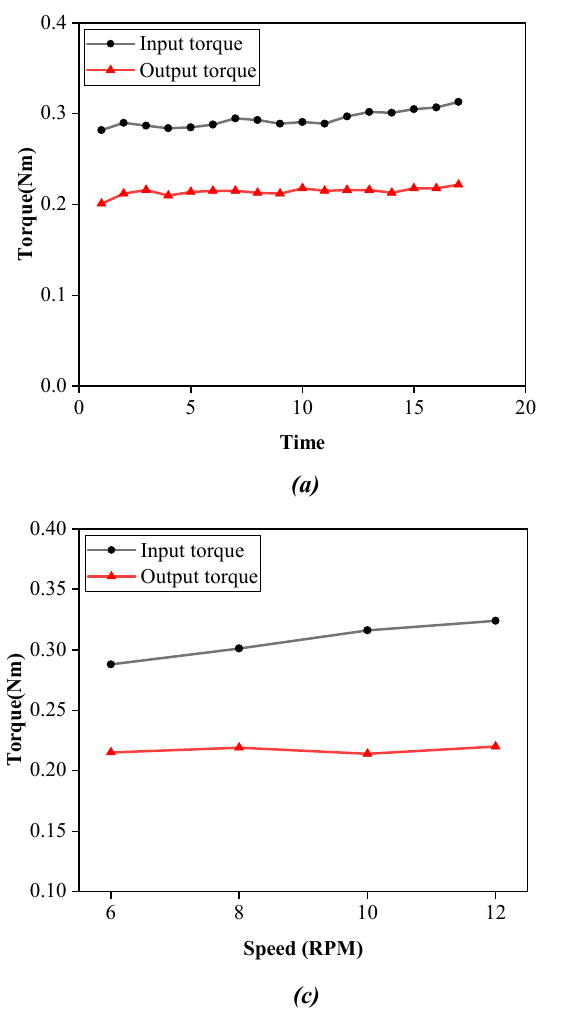
Figure 10. Experimental data curve of lasso input and output characteristics. ( a ) Data diagram of lasso input and output torque; ( b ) Torque-curvature radius diagram; ( c ) Torque-speed diagram.